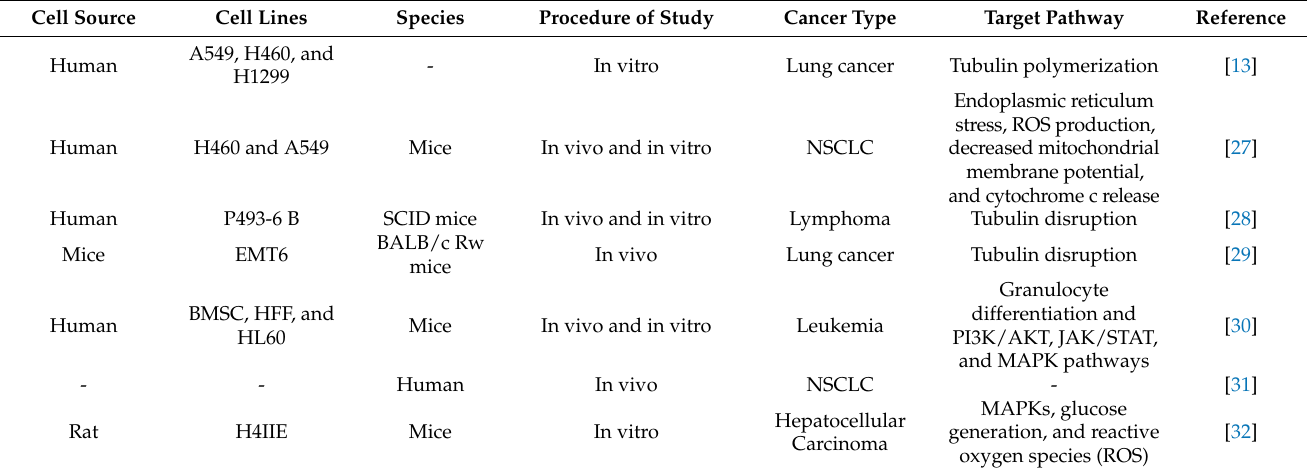
Table 1. Anticancer activity of